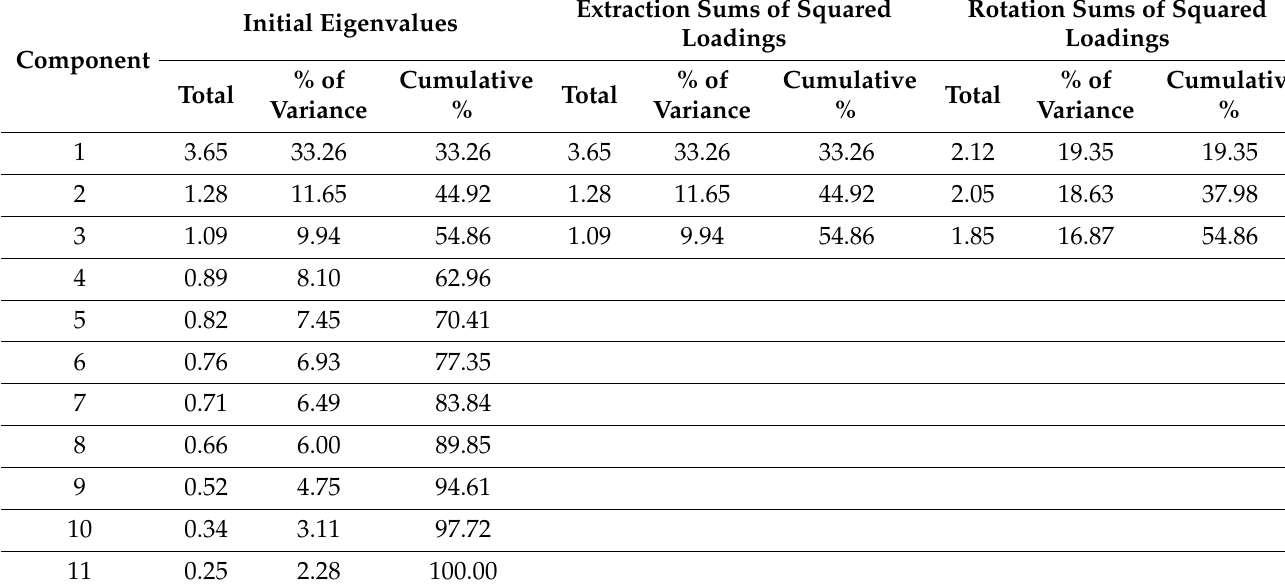
Table 9. The three extracted